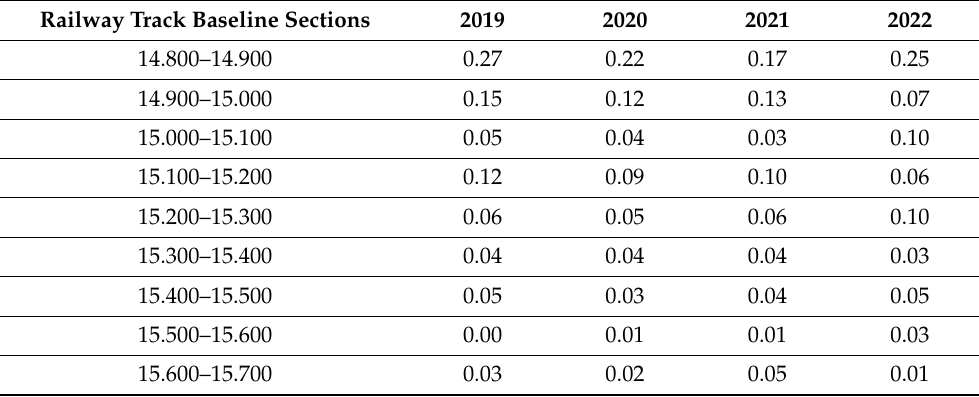
Table A13. Estimates of the railway track condition—relative D 6 object No. R 144_1. Railway Track Baseline